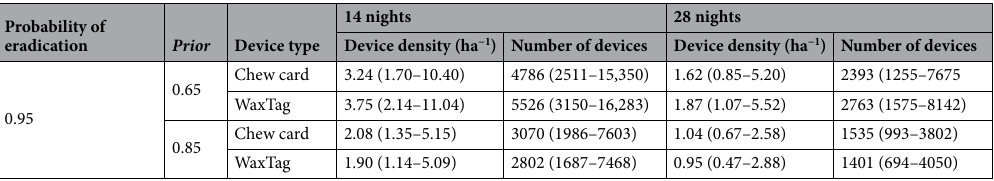
Table 3. Estimated median (and 90% credible intervals) number of detection devices and device density needed to achieve a 95% probability of declaring ship rat ( Rattus rattus ) eradication (given no rat detections) for various combinations of Prior and deployment time, for two monitoring devices (chew cards and WaxTags). The number and density of devices was simulated using the web-based tool ‘JESS for Pests’ over a 1475 ha that will be targeted for ship rat eradication in Wellington city, New Zealand. Prior is the estimated probability that eradication was successful before any surveillance was carried out.